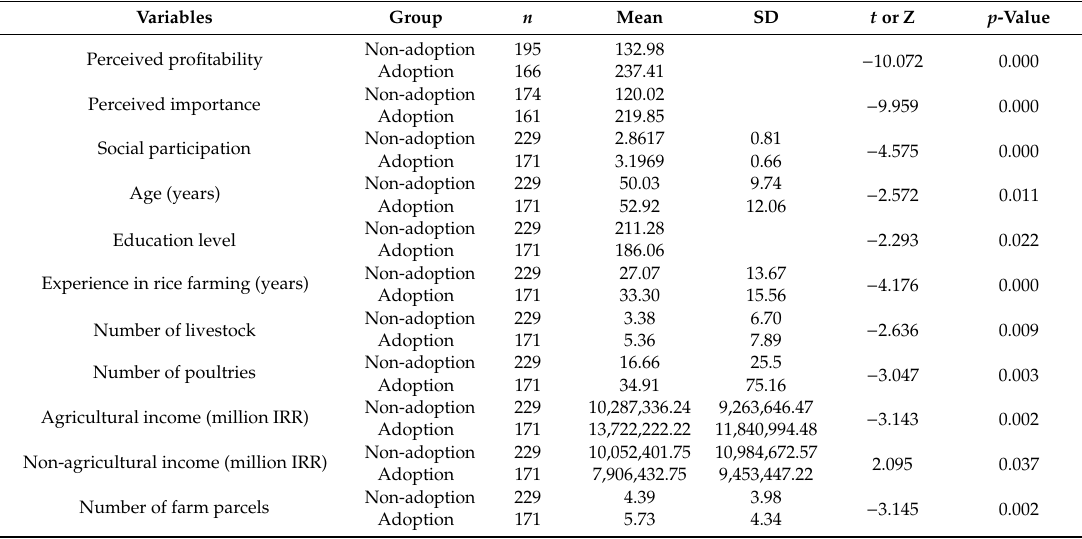
Table 7. Di ff erences between adopters and non-adopters of improved cultivars among rice growers of Rudsar County ( t -test and Mann–Whitney test).